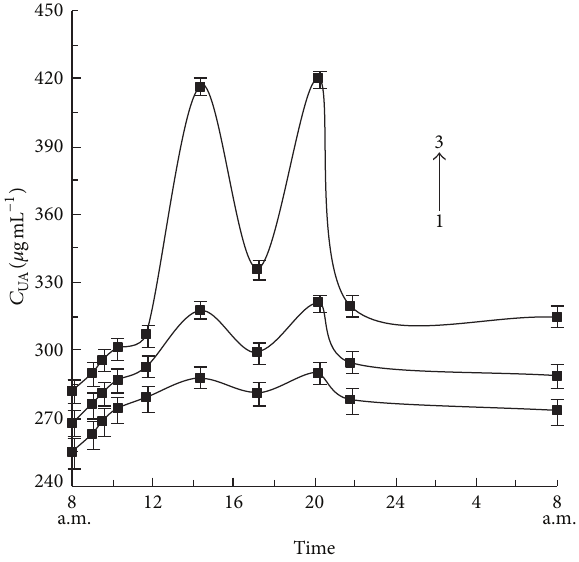
Figure 5: Metabolism of UA in human urine with different food during 24 h. Curve 1: porridge; Curve 2: vegetables; Curve 3: